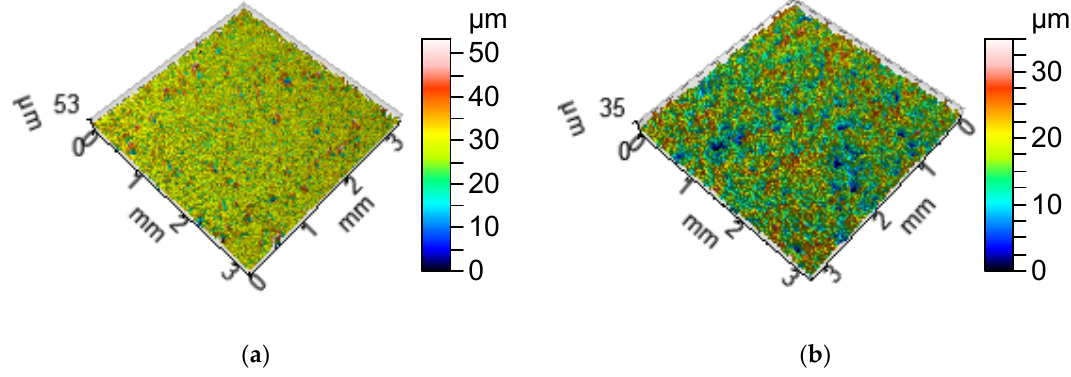
Table 1. Surface topography parameters of disc samples.